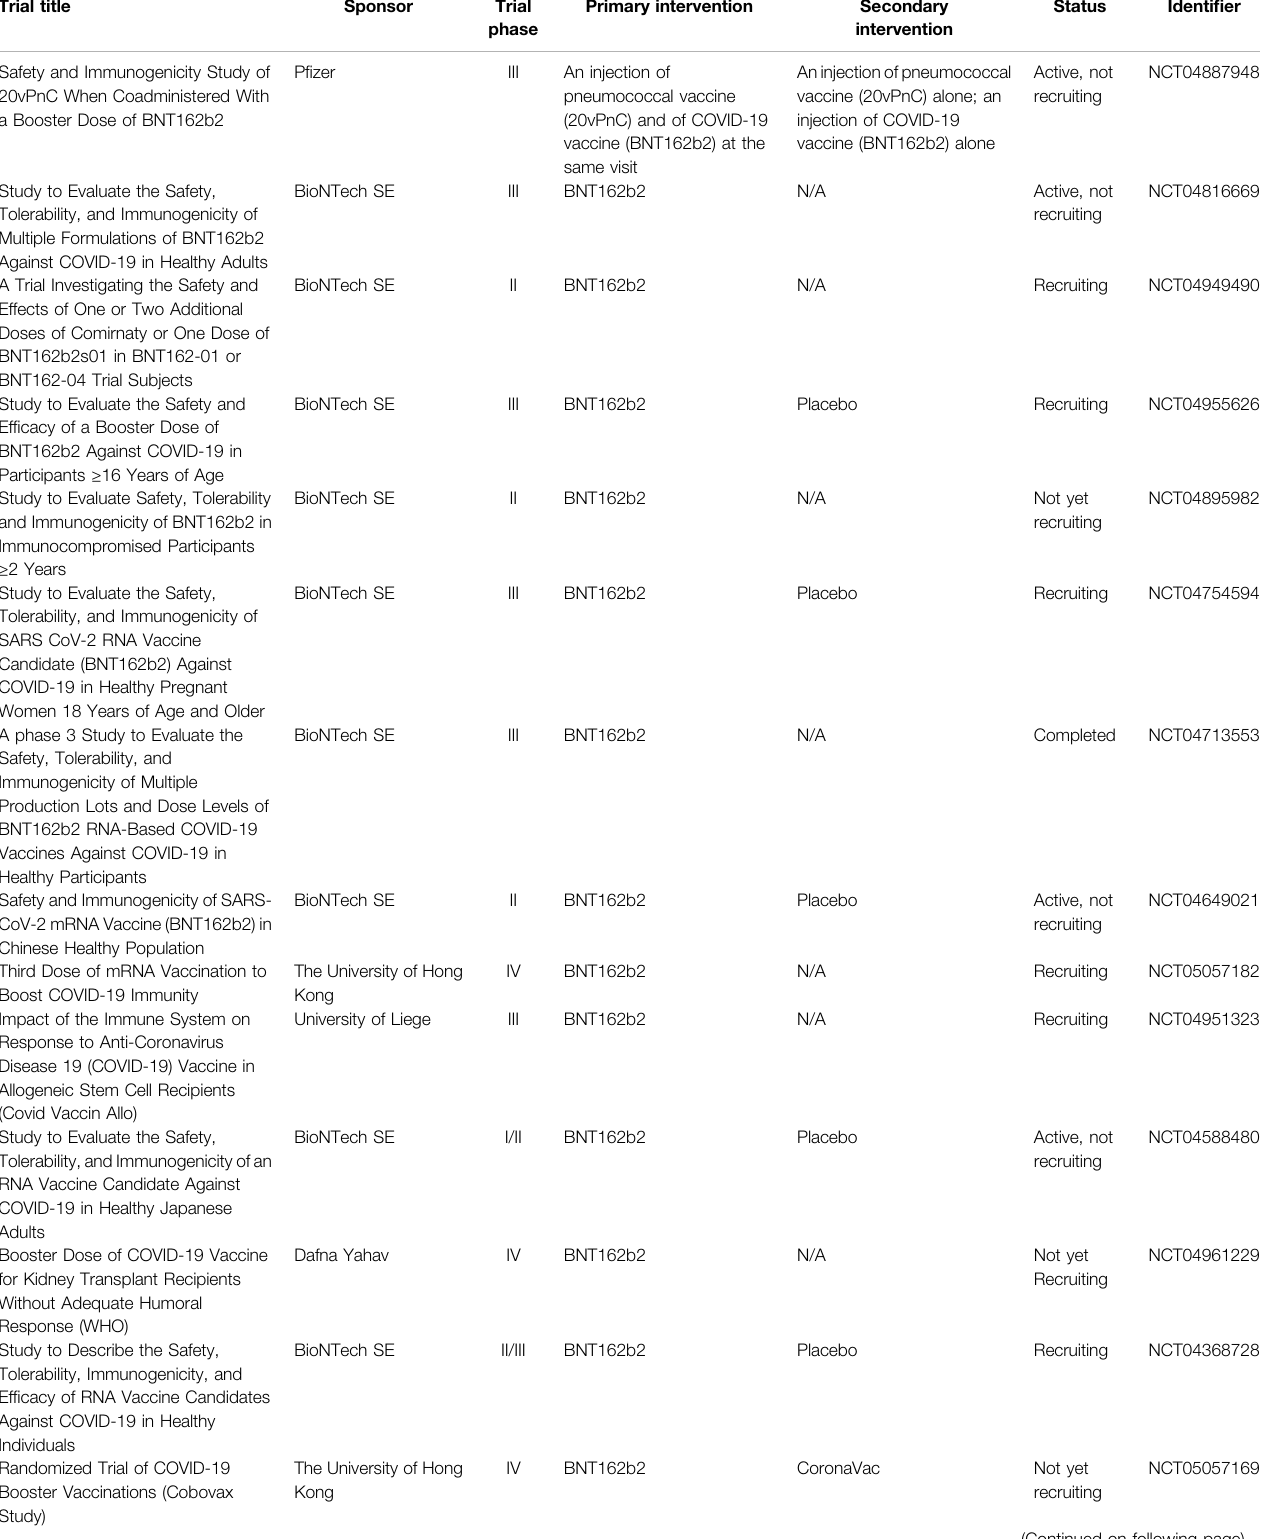
TABLE 10 | Summary of clinical trials of BNT162b2 vaccine (produced by P fi zer-BioNTech) on COVID-19